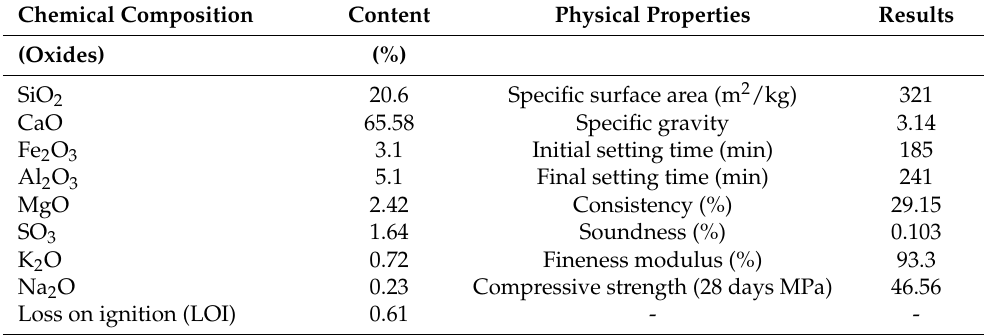
Table 1. Physical and chemical properties of OPC.